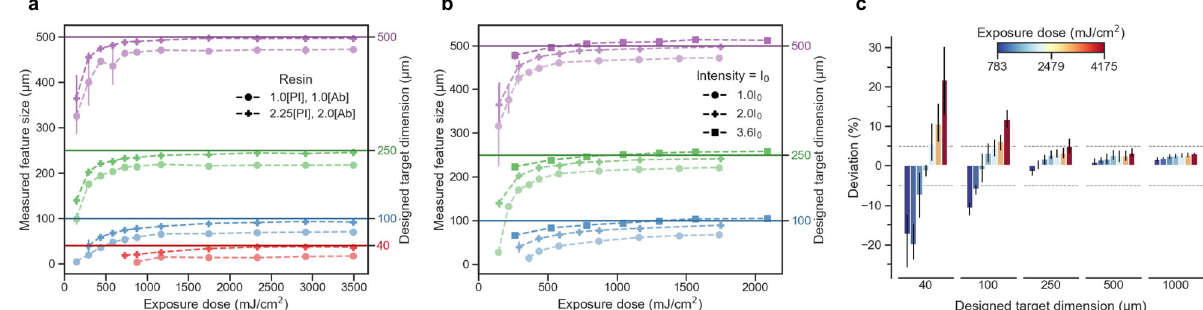
Fig. 3 Lateral resolution as a function of process conditions using discrete growth. a The effect of modifying resin properties by varying the concentration of photoinitiator, [PI], and absorbing dye, [Ab], on the convergence of polymerized feature size to the target dimension. b The effect of increasing the exposure intensity on speed of polymerization and convergence to the target dimension. c Accuracy and variation, given as percent deviation from target dimension, of polymerized features as a function of exposure dose while keeping exposure intensity and resin properties constant. The vertical error bars in a – c represent the standard deviation of duplicated features over the entire projection